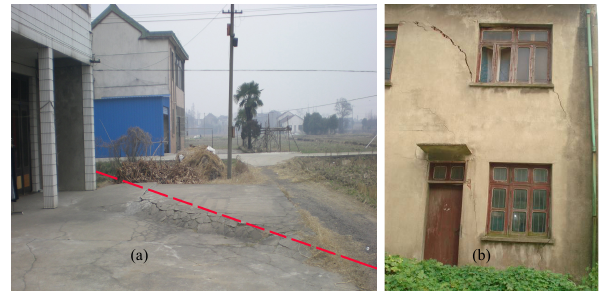
Figure 2. The ground rupture (a) and damaged house (b) at Guang- ming Village (red line in (a) shows the direction of the earth